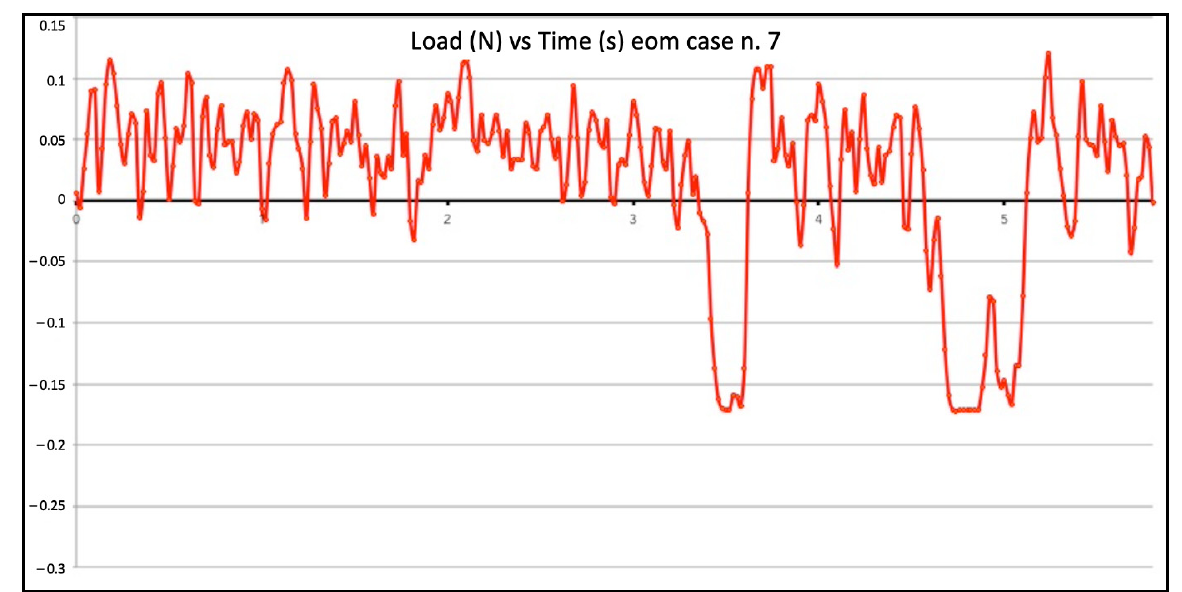
Figure 8. Graphic plot of the simulation on model n. 7 (successful envelope of motion negotiation).